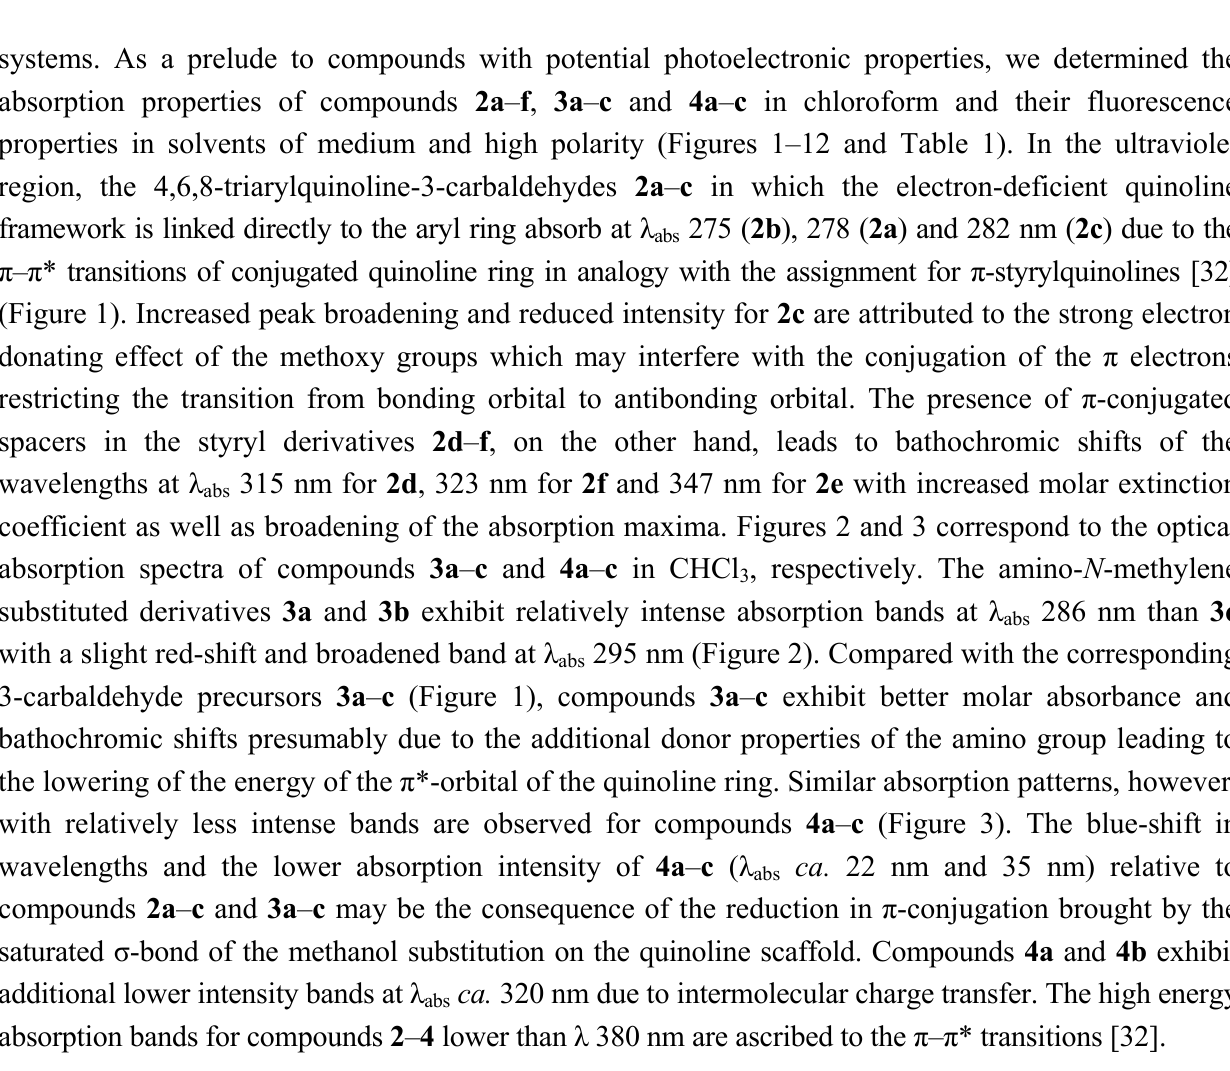
Figure 1. UV-Vis spectra of 2a – f in CHCl